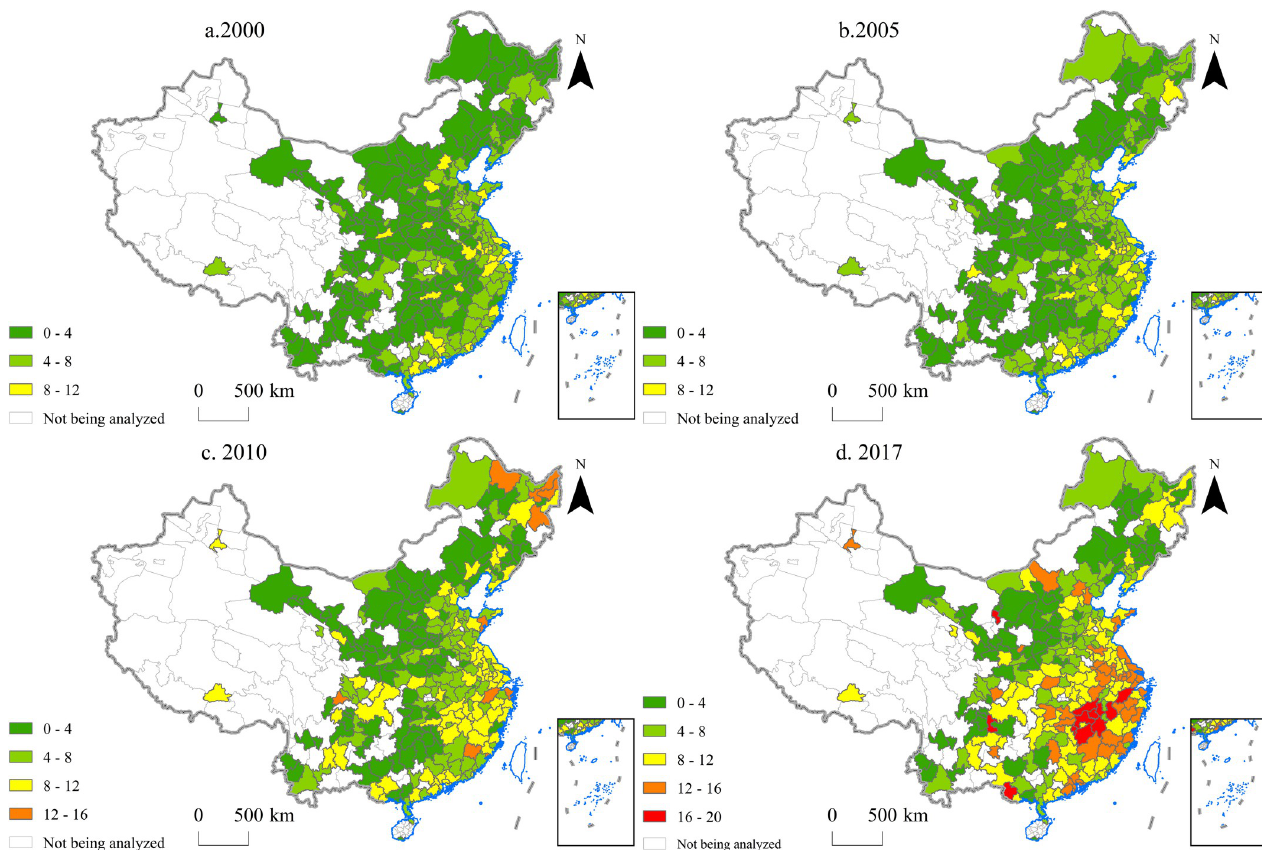
Fig 5. Average export similarity index (AESI) of the 270 Chinese cities analyzed in this study.